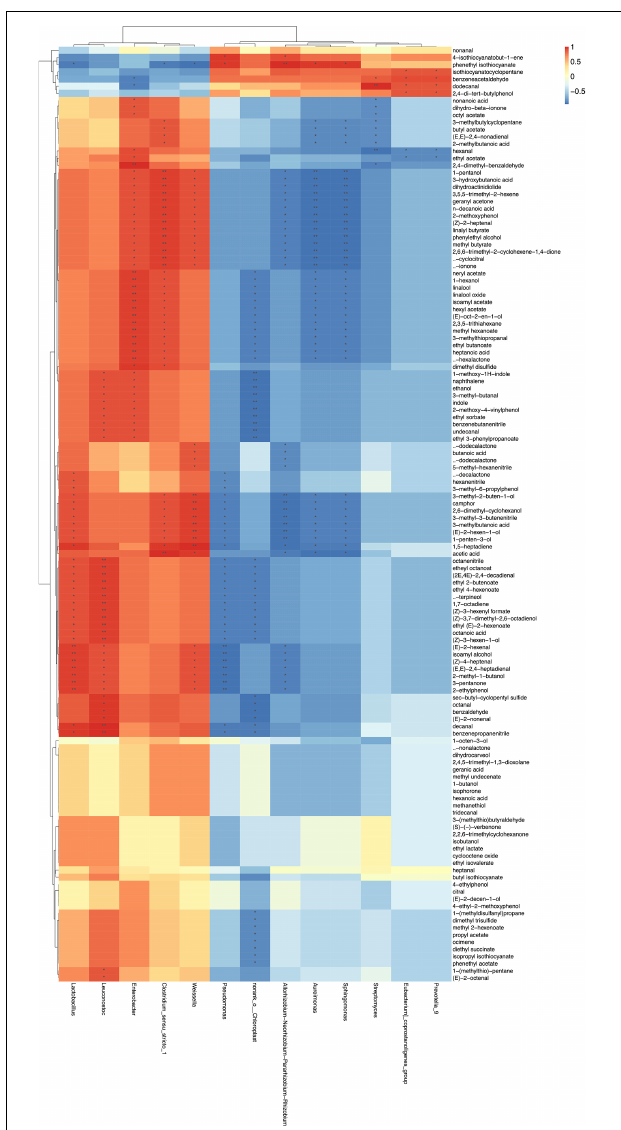
FIGURE 7 | Heatmap of the correlations between microbiota and volatile metabolites. The red color represented positive correlation and the blue color represented negative correlation. “*” represented the significance of relationship, “*” represented 0.01 < p ≤ 0.05, “**” represented 0.001 < p ≤